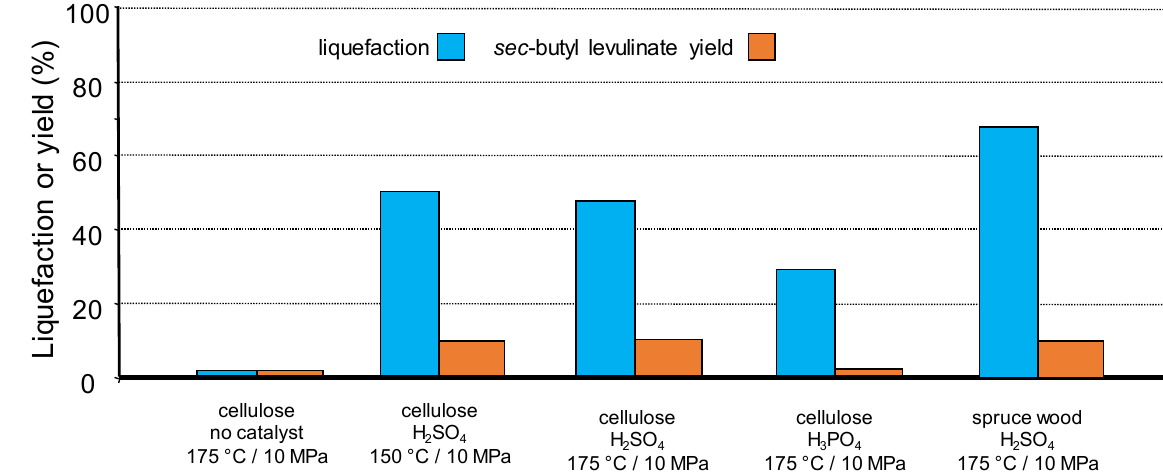
Figure 11. Biomass liquefaction and sec-butyl levulinate formation after treatment under super-critical 2-butene (flow 0.1 mL · min − 1 , reactant 2 g, 10 MPa He, 1.5 h).